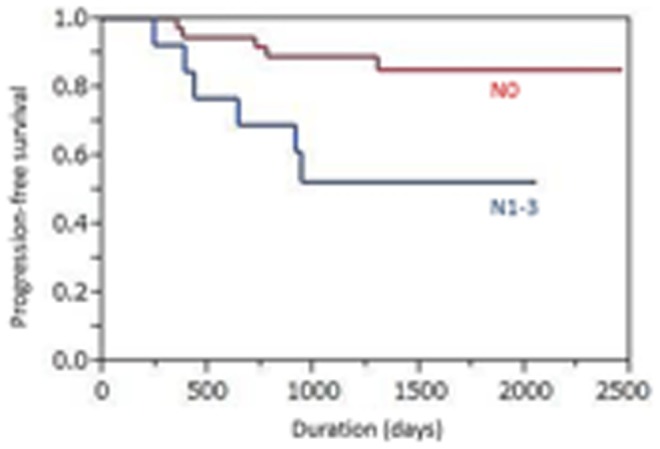
The positive lymph node status (N1-3) subgroup showed a significantly shorter median progression-free survival time than the N0 subgroup (31.3 vs. 50.9 months; p = 0.0099).